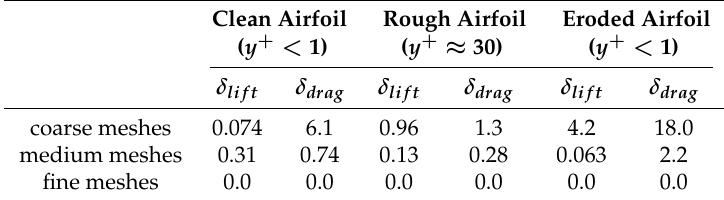
Table 2. Relative differences δ lift , δ drag in (%) of lift and drag coefficients compared to the coefficients resulting from the fine meshes (differences are presented as absolute values).